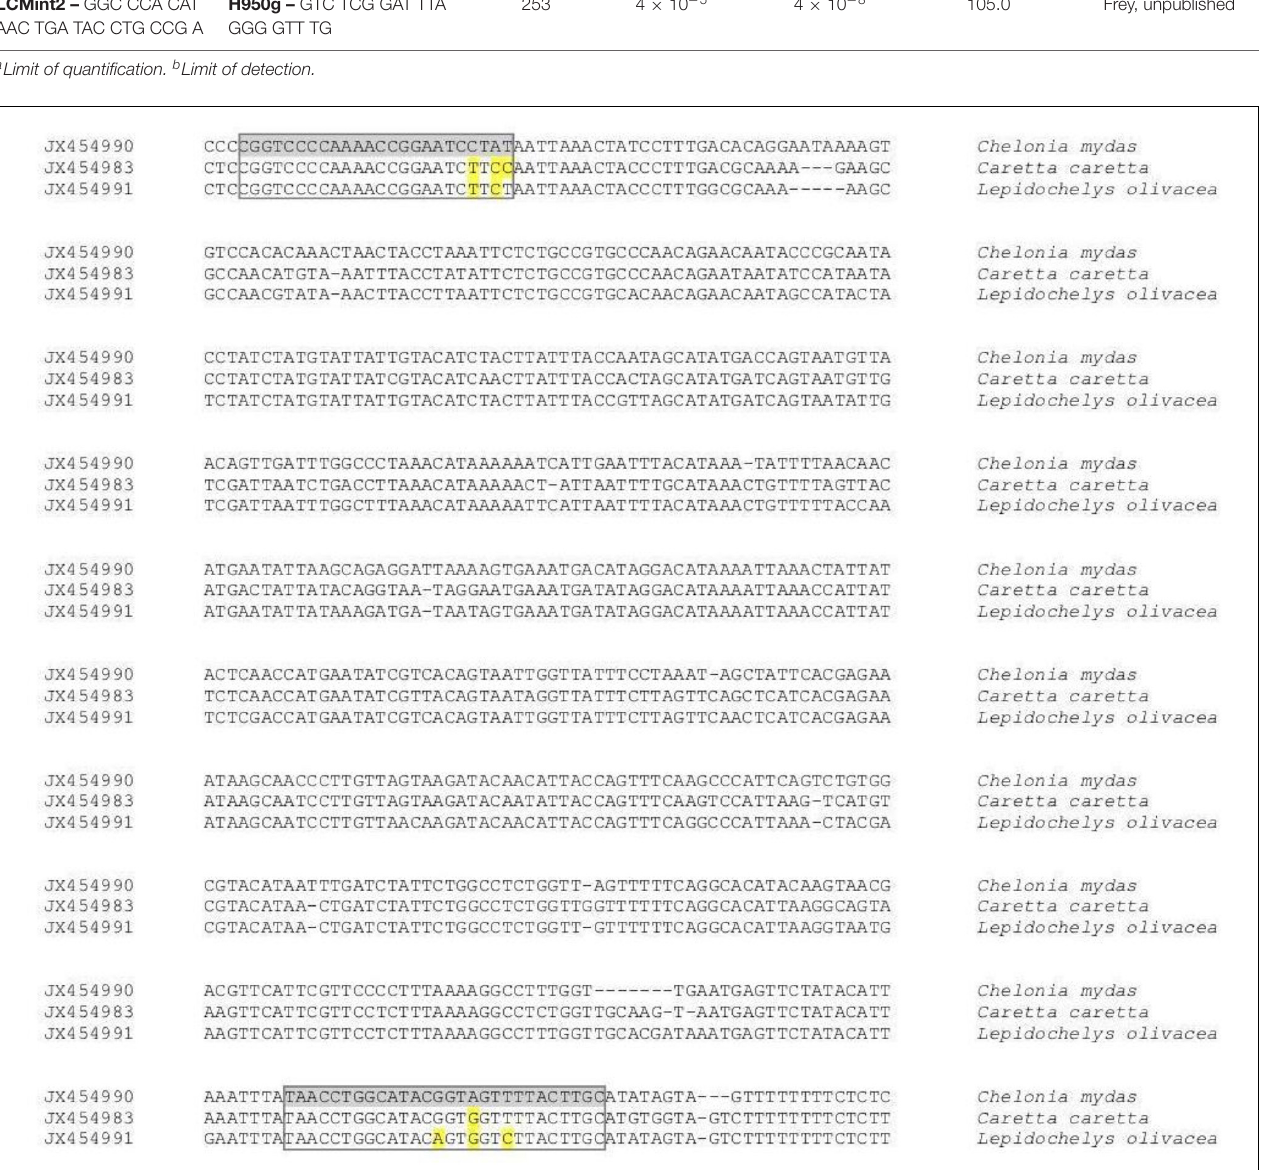
Mammal and Sea Turtle Research (MMASTR) Collection at the Southwest Fisheries Science Center, La Jolla, CA, United States, and consisted of one individual from each of the species listed above.